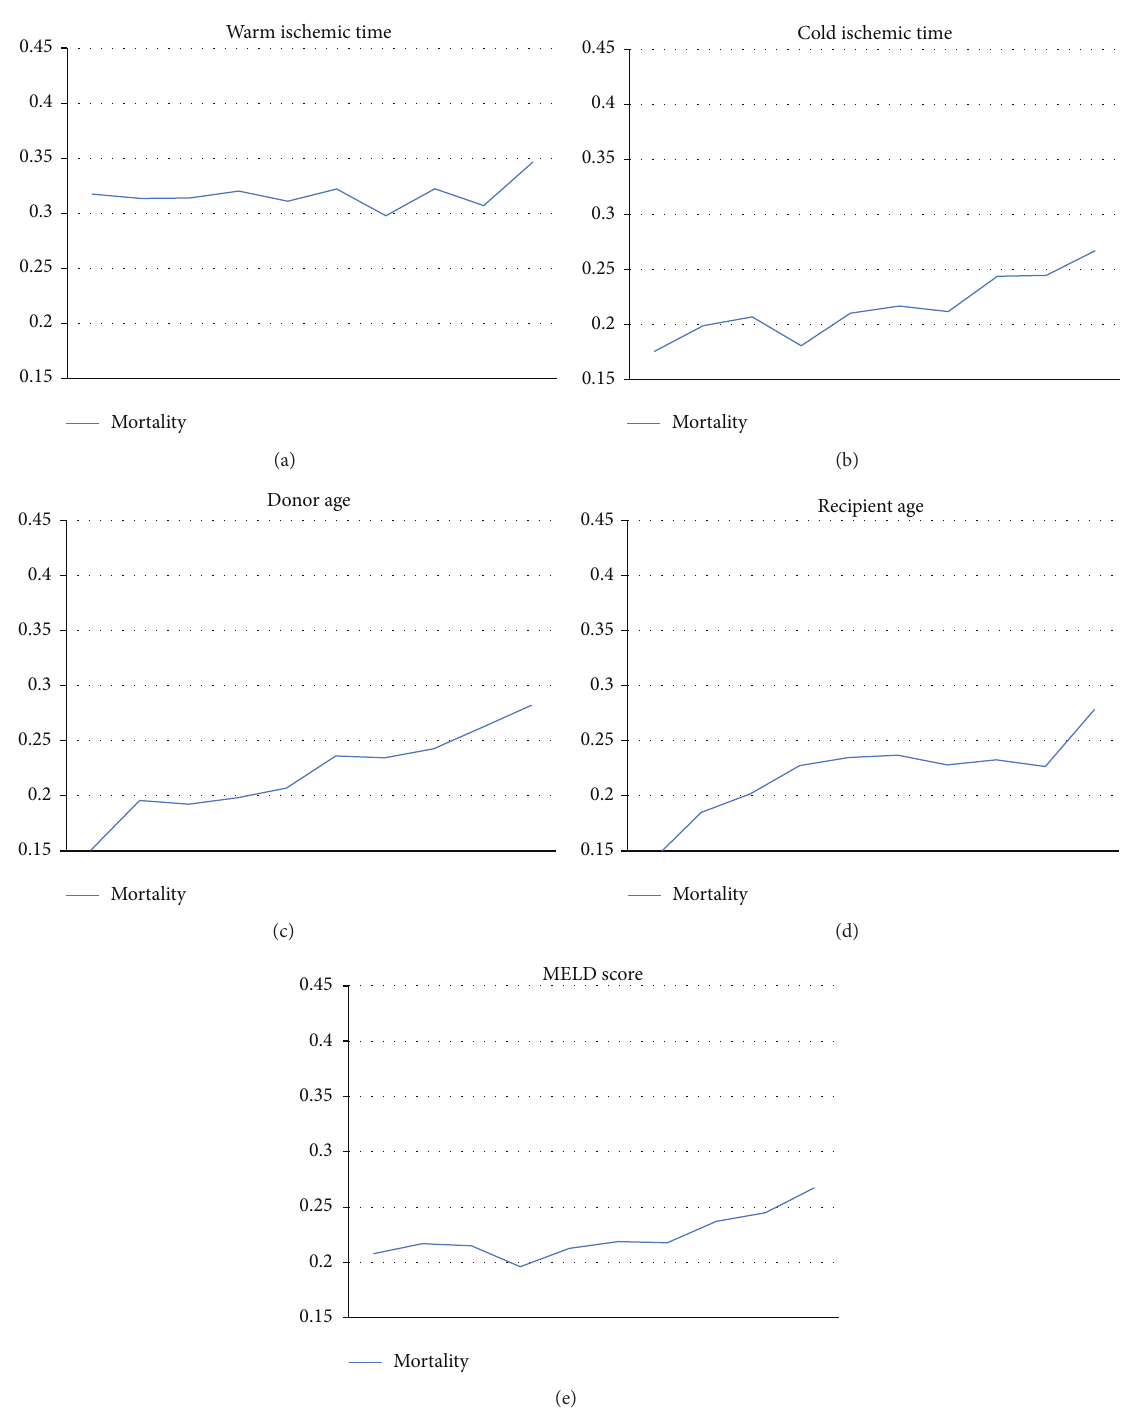
Figure 3: Unadjusted contributions of continuous factors to risk of death. (a) Warm ischemic time (WIT). On multivariate analysis, WIT does not reach significance ( 𝑝 > 0.05 ). (b) Cold ischemic time (CIT) contributes to 2.0% increased graft failure risk per hour. (c) Donor age increases graft failure risk by 1.5% per year of age. (d) Recipient age contributes to 1.7% per year of age. (e) Graft failure rates increase by 1.0% per MELD